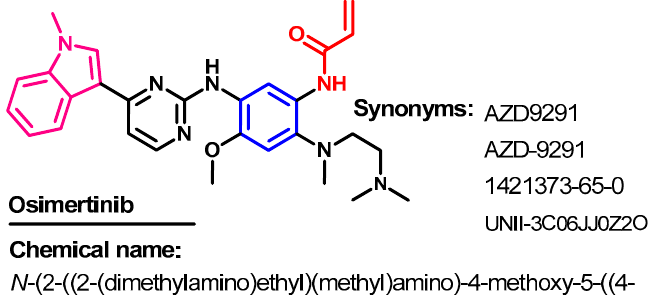
Figure 51. Chemical structure, name, and synonyms of osimertinib.